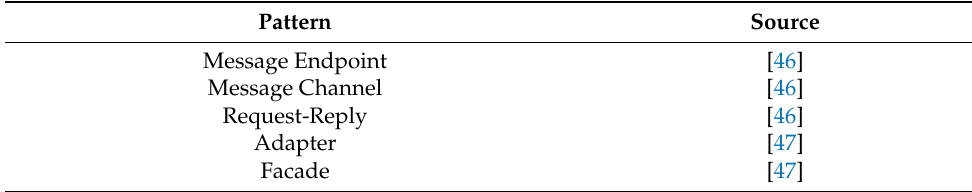
Figure 1. End-to-end conceptual design of the solution. Table 1. Patterns and their